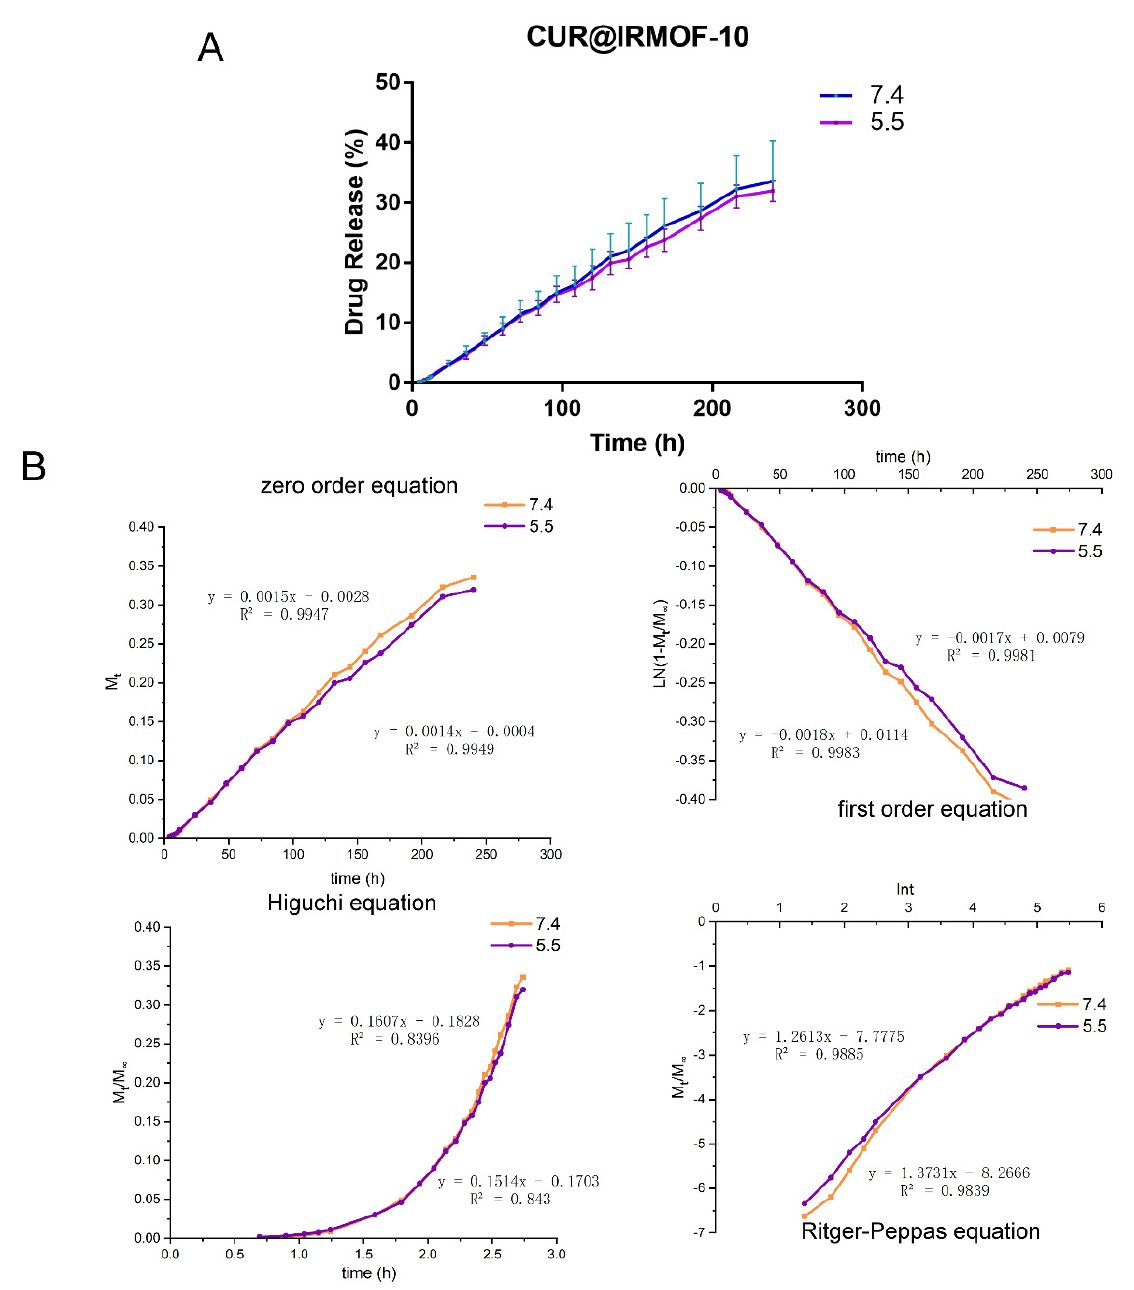
Figure 6. Release characteristics of CUR@IRMOF-10: ( A ) release curve of CUR@IRMOF-10 under different pH conditions ( n = 3); ( B ) fitting curve of CUR@IRMOF-10 by different mathematical models under different pH values (5.5 and 7.4).